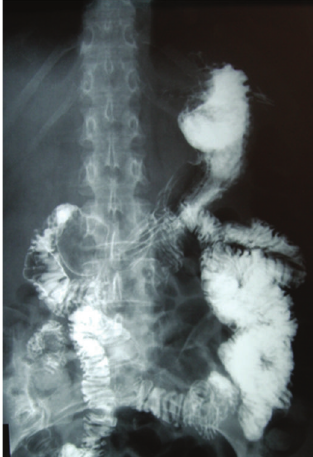
Figure 3: Upper GI shows the relief of obstruction by contrast moving distally, once the patient was placed in prone